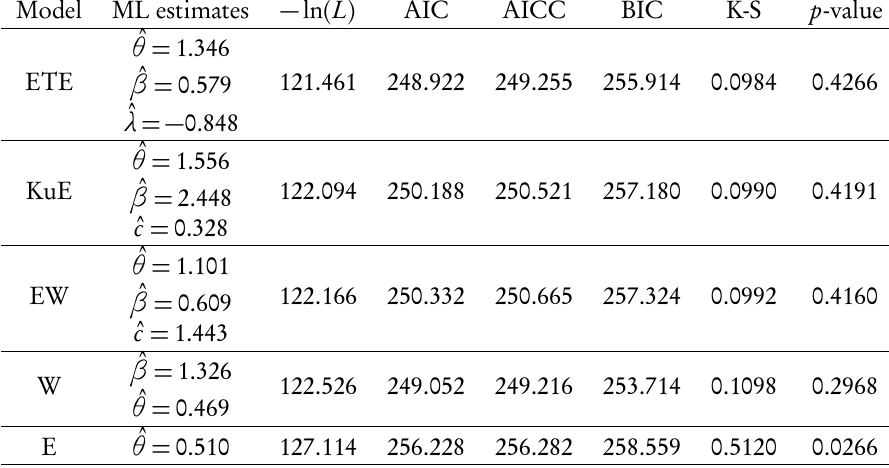
Parameter estimates and goodness of fit statistics for various models fitted for the first data